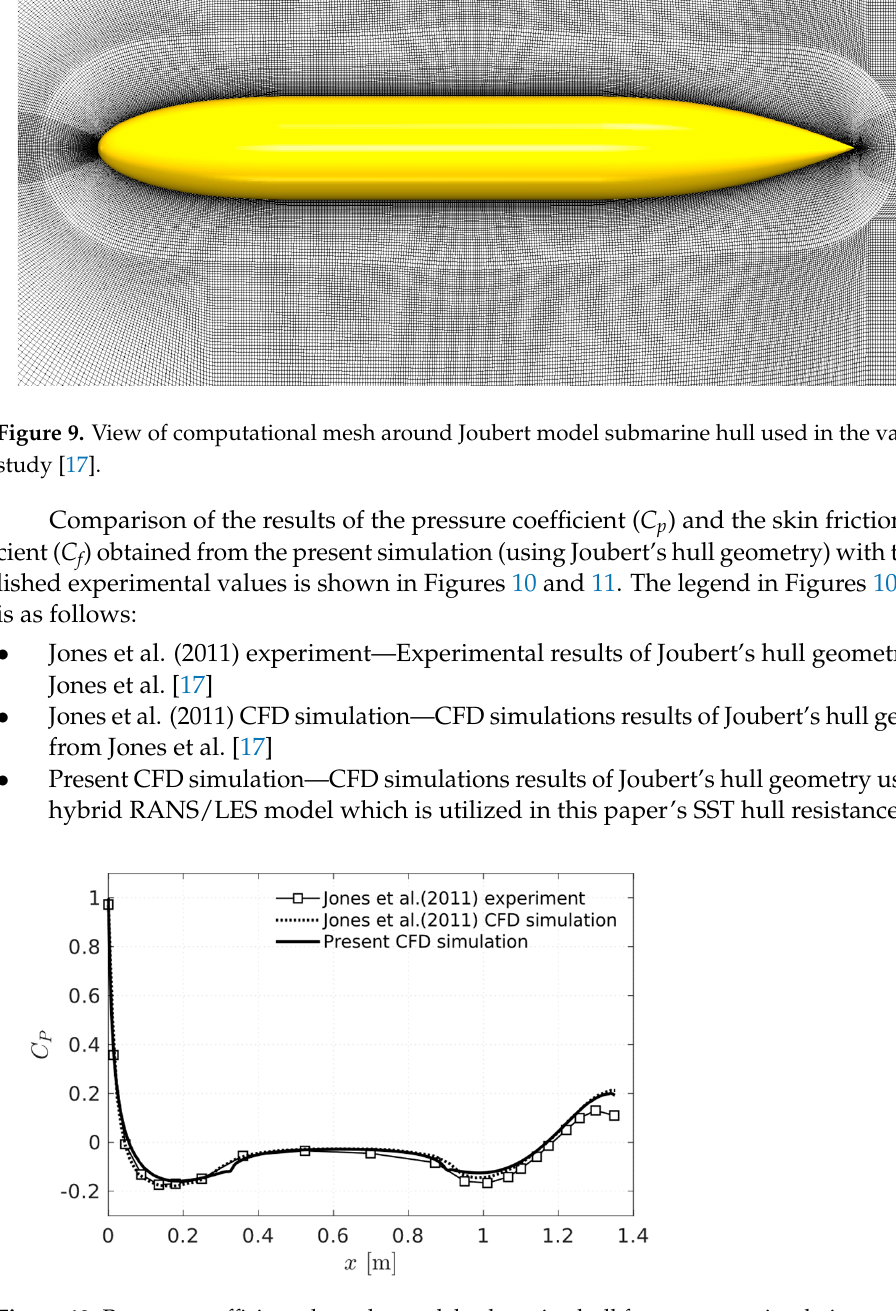
imental measurements by Jones et al. [17]. mental measurements by Jones et al.